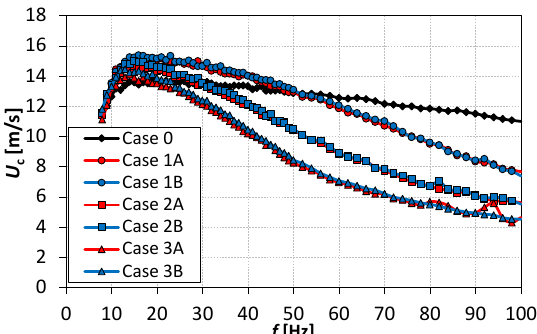
Figure 2. The centerline momentum velocity as a function of frequency at p = 3 W, x = 0.